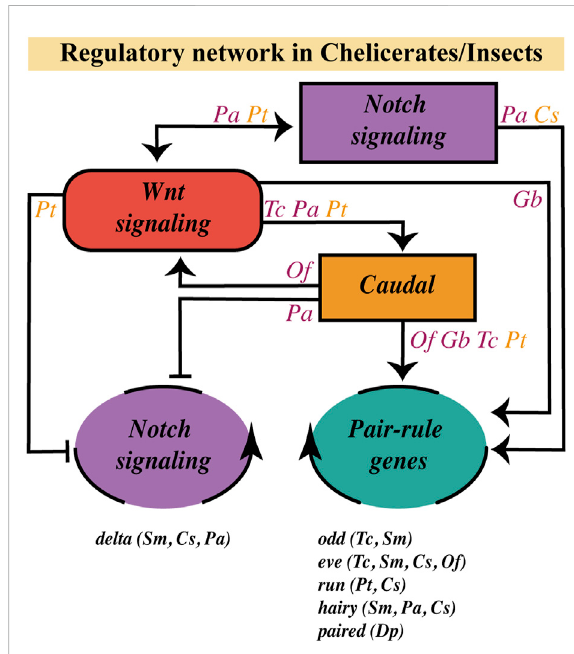
FIGURE 5 Wnt pathway role on the segmentation gene network at the SAZ. Regulatory relationships of the Wnt signaling pathway with the Notch pathway, the caudal gene and the dynamic/oscillatory genes (belonging to the Notch pathway or to the Pair-Rule gene family) in the SAZ, based on current evidence in chelicerates (orange letters) and insects (purple letters). Genes with a dynamic/ oscillatorybehaviorattheSAZindifferentarthropodsareshownat the bottom. C. salei ( Cs ); D. pulex ( Dp ); G. bimaculatus ( Gb ); O. fasciatus ( Of ); P. americana ( Pa ); P. tepidariorum ( Pt ); S. maritima ( Sm ); T. castaneum ( Tc